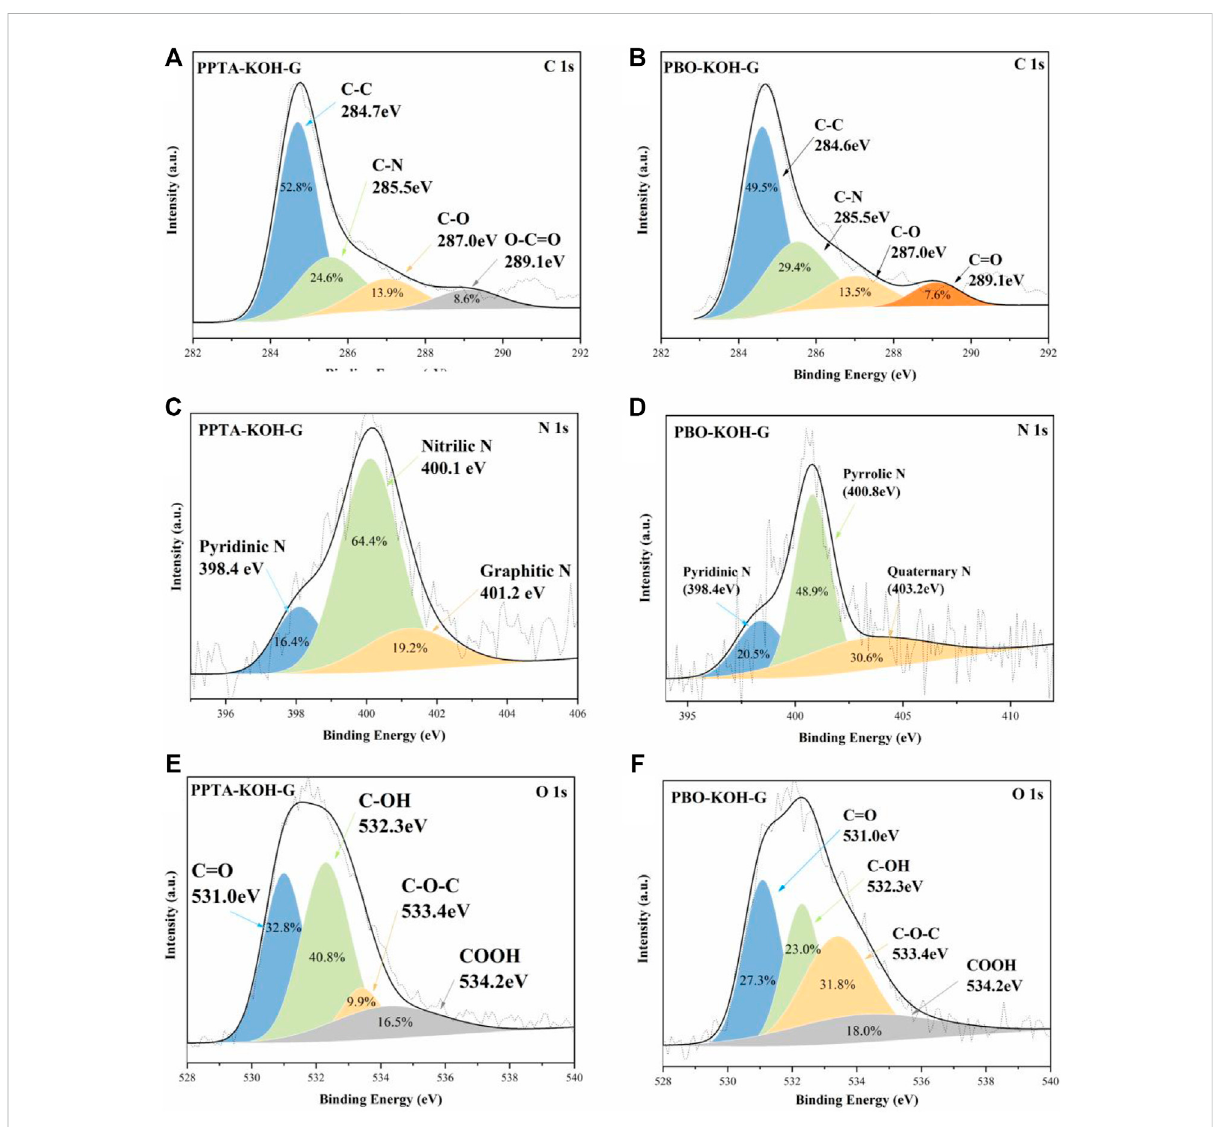
which display mesopores and micropores coexisted for both PBO- KOH and PPTA-KOH. PBO-KOH has a higher proportion of micropores and larger pore volume than PPTA-KOH. The surface force relative to the pore wall plays a dominant role in micropore adsorption, while the surface force together with capillary force is signi fi cant in mesopore adsorption. Generally, carbon materials have two characteristic G (1,600 cm − 1 ) and D (1,360 cm − 1 ) peaks for sp 2 atoms in Raman spectra, which represent the bond stretching of chains and rings and the breathing modes of rings (structural imperfection) (Wu et al., 2019), respectively. The I D /I G value is smaller for